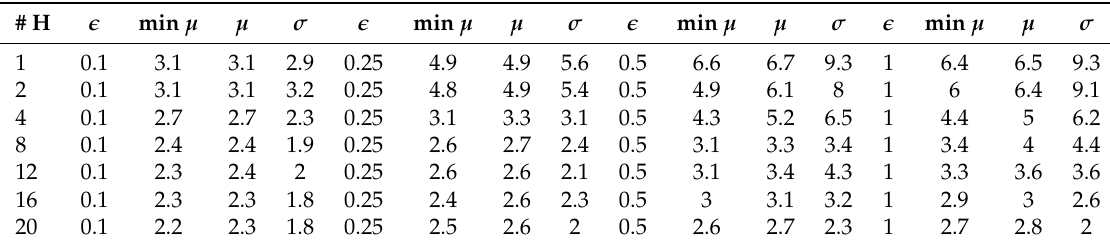
Table 2. MHDE results for heteroscedastic noise conditions on the KITTI [26] dataset for endpoint error (EPE) with 1–20 hypotheses